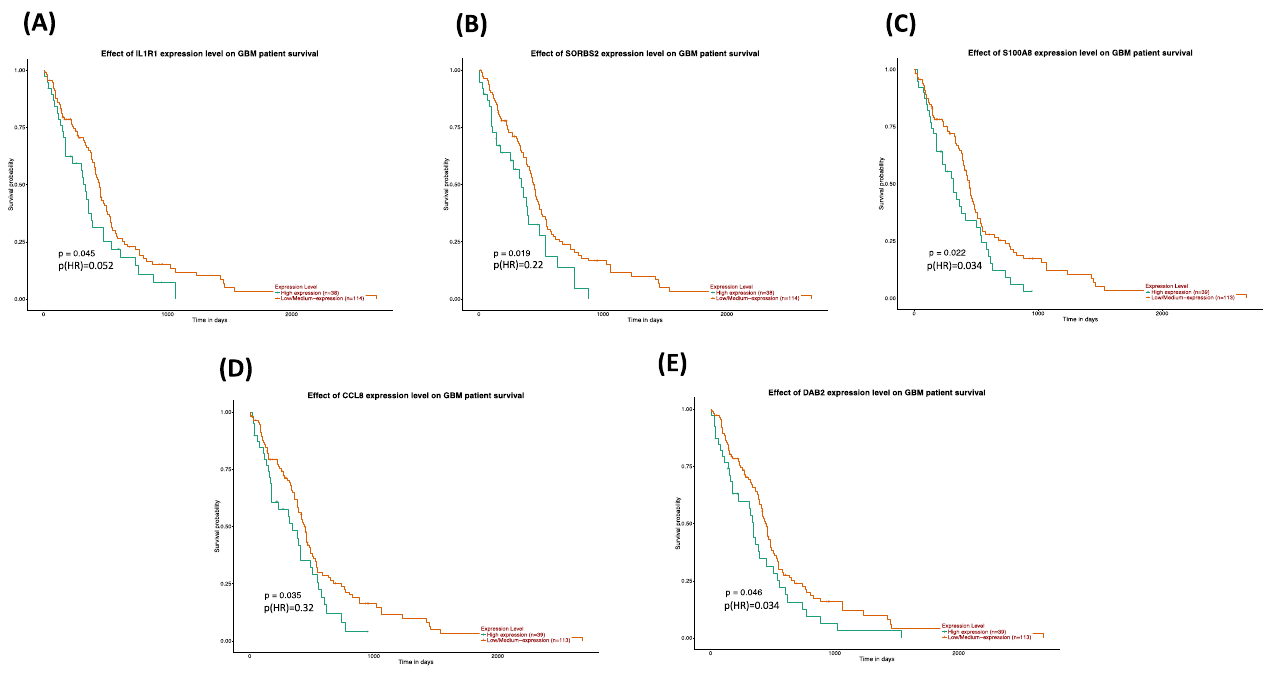
Figure 7. Survival analysis of Kaplan–Meier (KM) plots of the most significant hub genes in the TCGA dataset via the UALCAN. ( A ) IL1R1 , ( B ) SORBS2 , ( C ) S100A8 , ( D ) CCL8 , and ( E ) DAB2 . Orange lines represent the low expression of the most significant hub genes, whereas green lines represent high expression. Table 5. The five most significant hub genes by average expression values in log 2 base for each treatment.